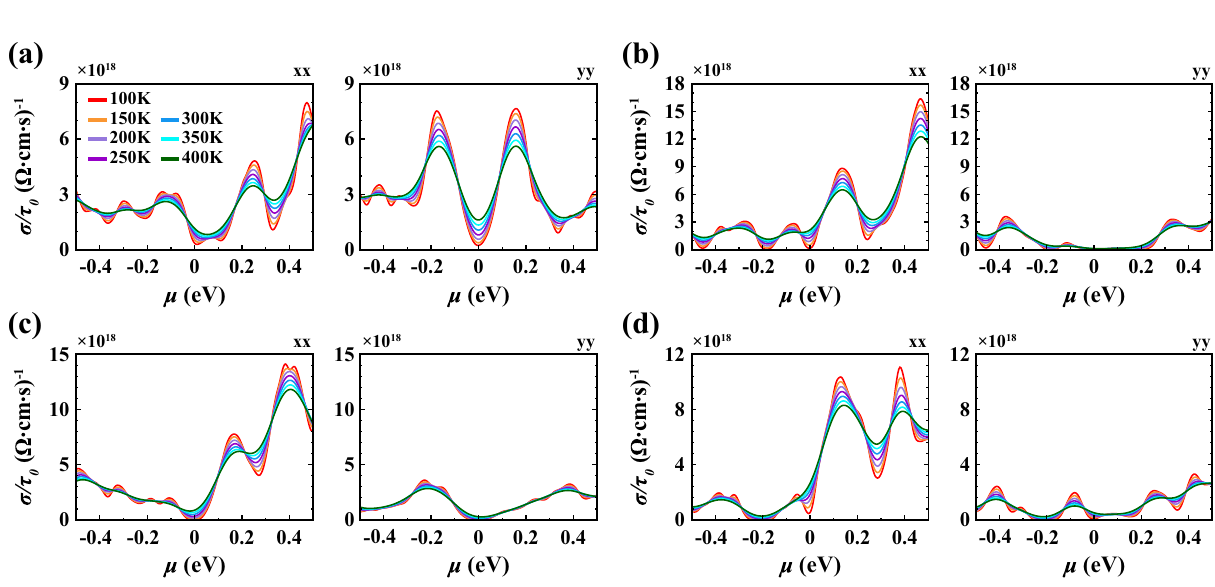
Figure 11. Electrical conductivity with respect to relaxation time ( σ/τ 0 ) calculated as a function of chemical potential ( µ ) at various temperatures along xx and yy lattice directions for ( a ) Te(1) vacancy, ( b ) Te(2) vacancy, ( c ) Te(1)- O 2 substitution with parallel orientation, ( d ) Te(2)- O 2 substitution with parallel